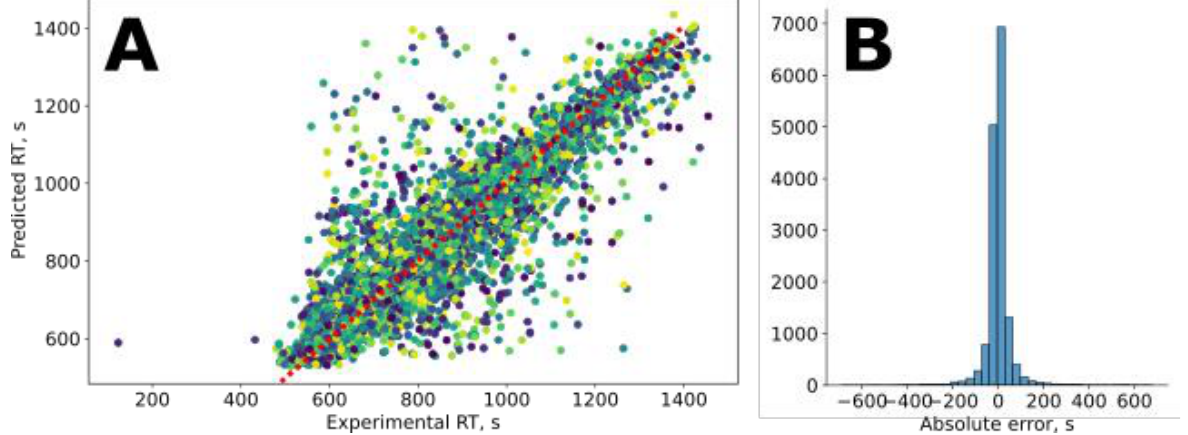
Figure 2. The results of retention predictions on the SMRT dataset: ( A ) predicted vs. experimental values for the test set; ( B ) error distribution plot. Table 1. Mean metrics for 5-fold cross-validation of MPNN on SMRT dataset compared with previ- ously published results.